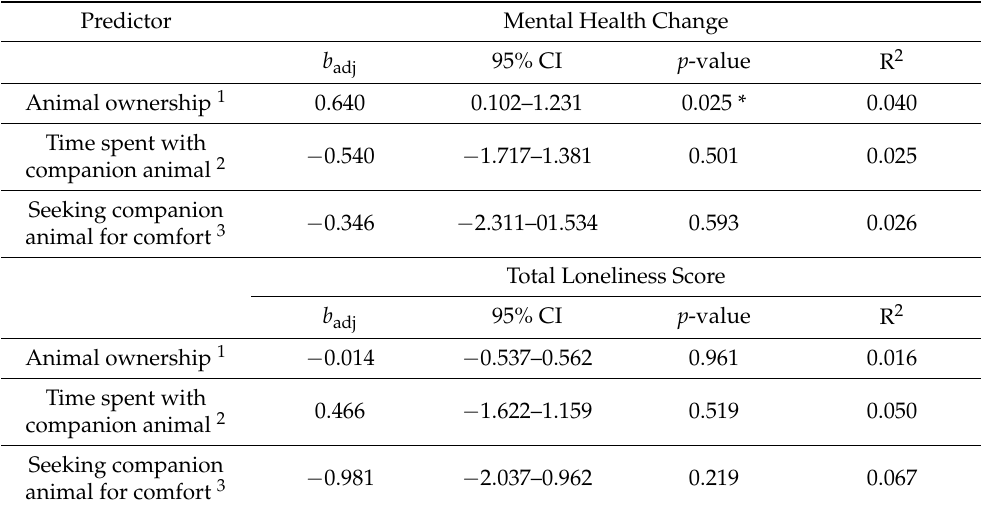
Table 3. Binary logistic regression models of association of predictors and self-reported change in mental and physical health, adjusting for relevant covariates.